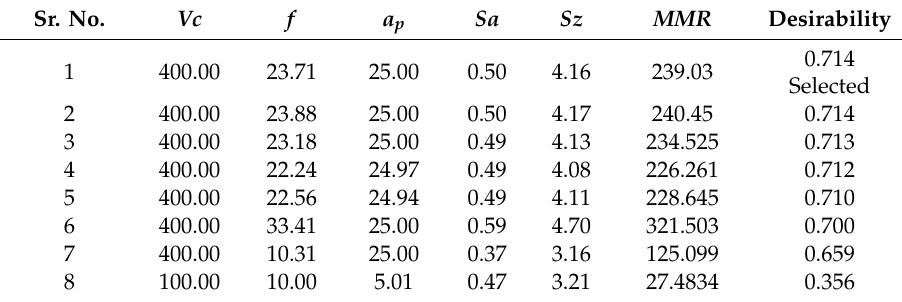
Table 12. Multi-objective optimization